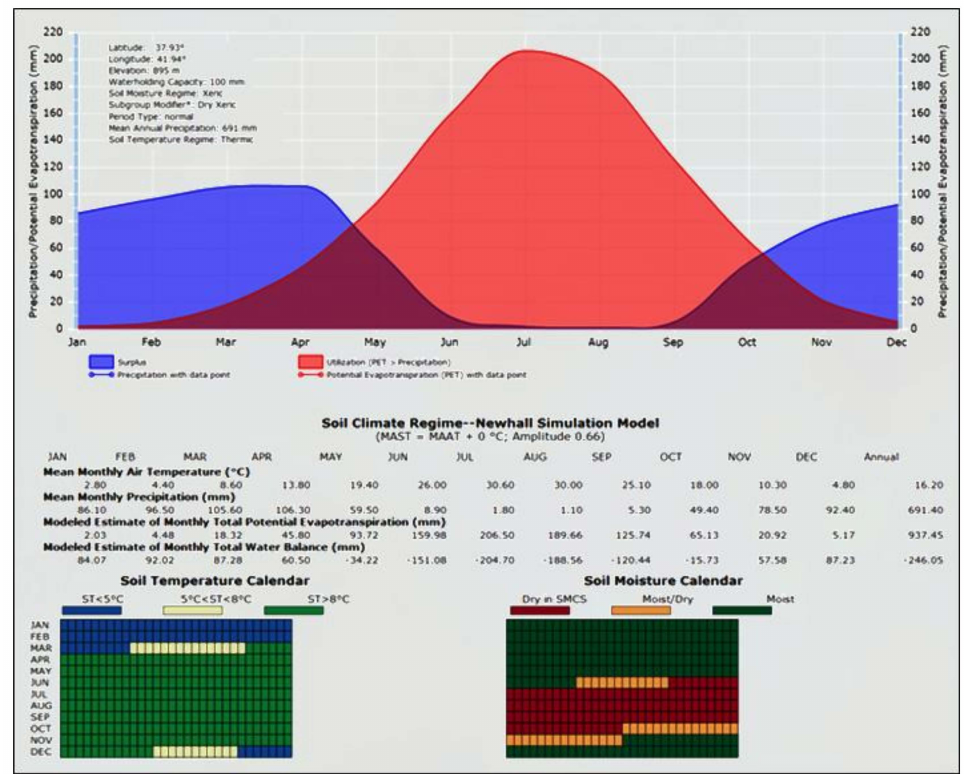
Figure 2. Soil moisture and temperature regime diagrams according to the Newhall simulation